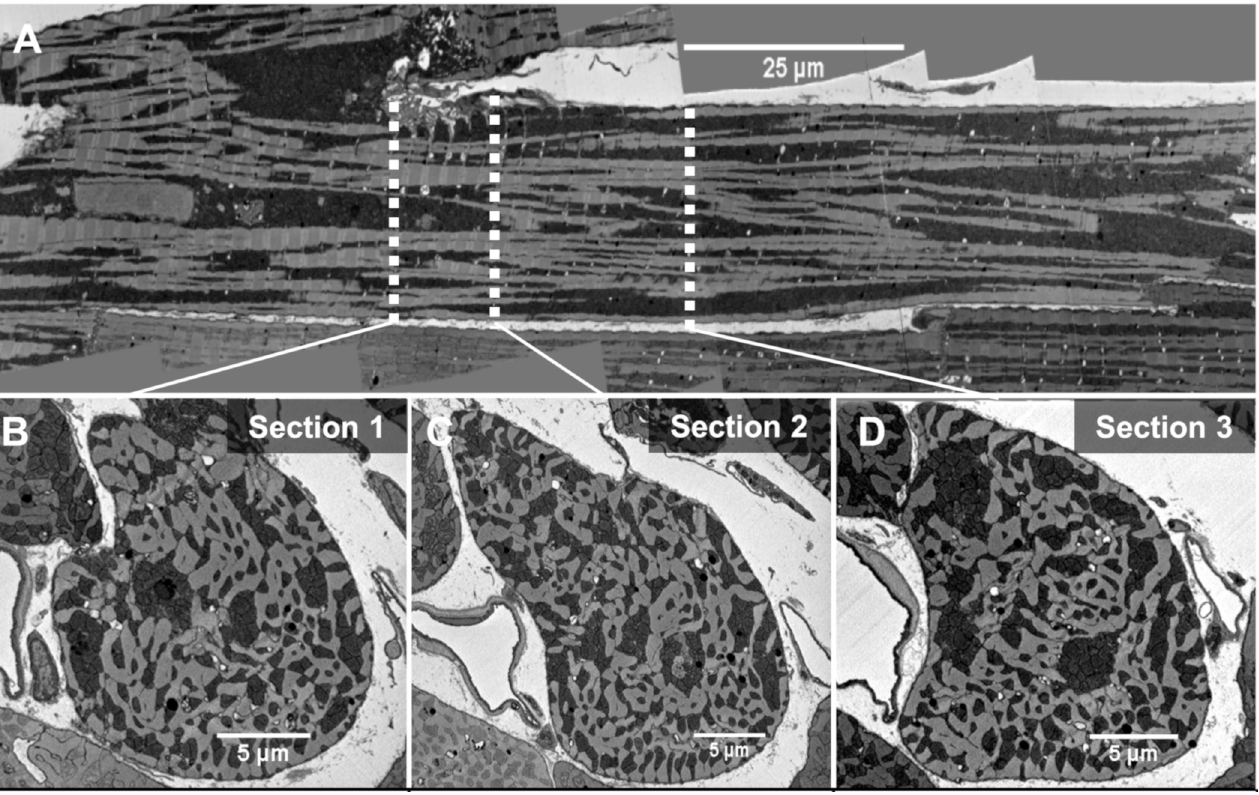
Fig 1. EM image of a single cardiac myocyte. (A): A Longitudinal section from the SBF-SEM images of a single cardiomyocyte with mitochondria in dark regions and myofibril/nucleus in light regions. (B-D): Cross sections (1–3) corresponding to the location of three white dotted lines in the longitudinal section. Section 1 is located near a branching point, and section 2 is located close to a nucleus, however none of the sections contain a nucleus.